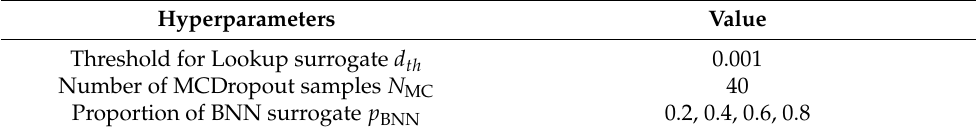
Table 7. Hyperparameters for